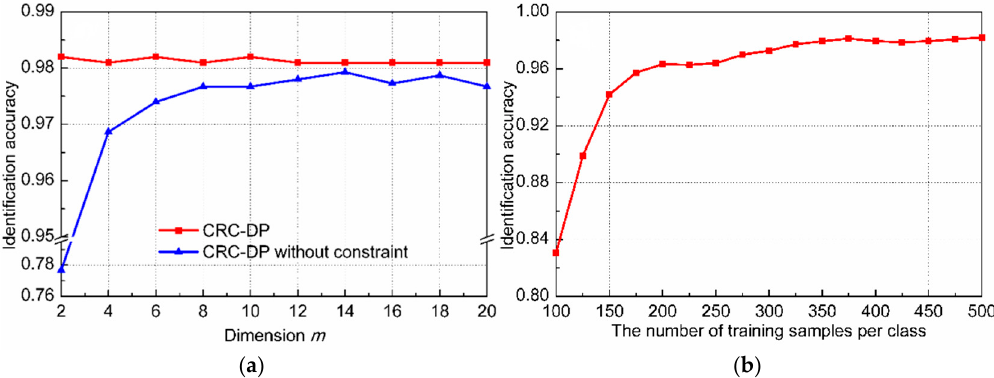
Figure 8. ( a ) Comparison results of the CRC-DP method with and without graph constraint; ( b ) identification accuracy versus the enrollment size by CRC-DP method.